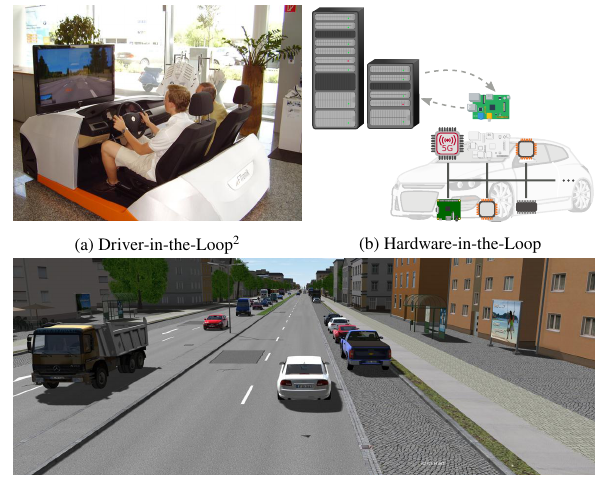
Figure 3. Testing within simulated